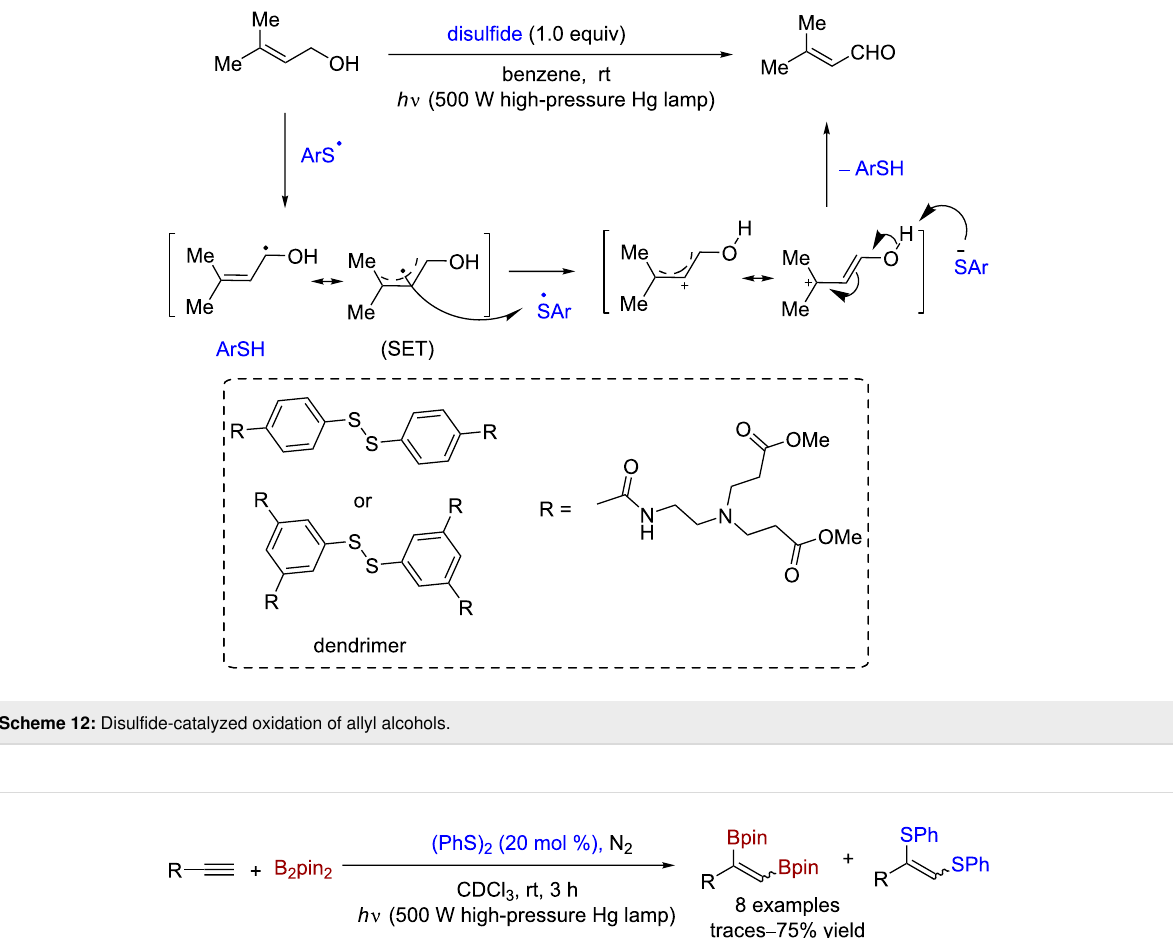
Scheme 12: Disulfide-catalyzed oxidation of allyl alcohols.